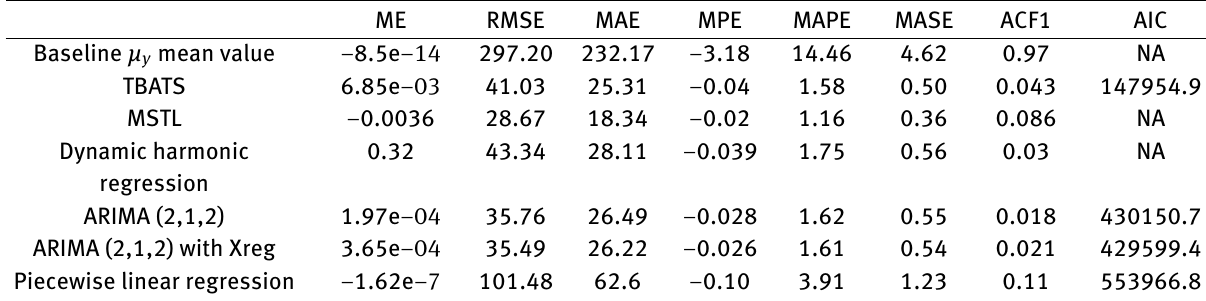
Table 1: Model accuracy for training data sets.